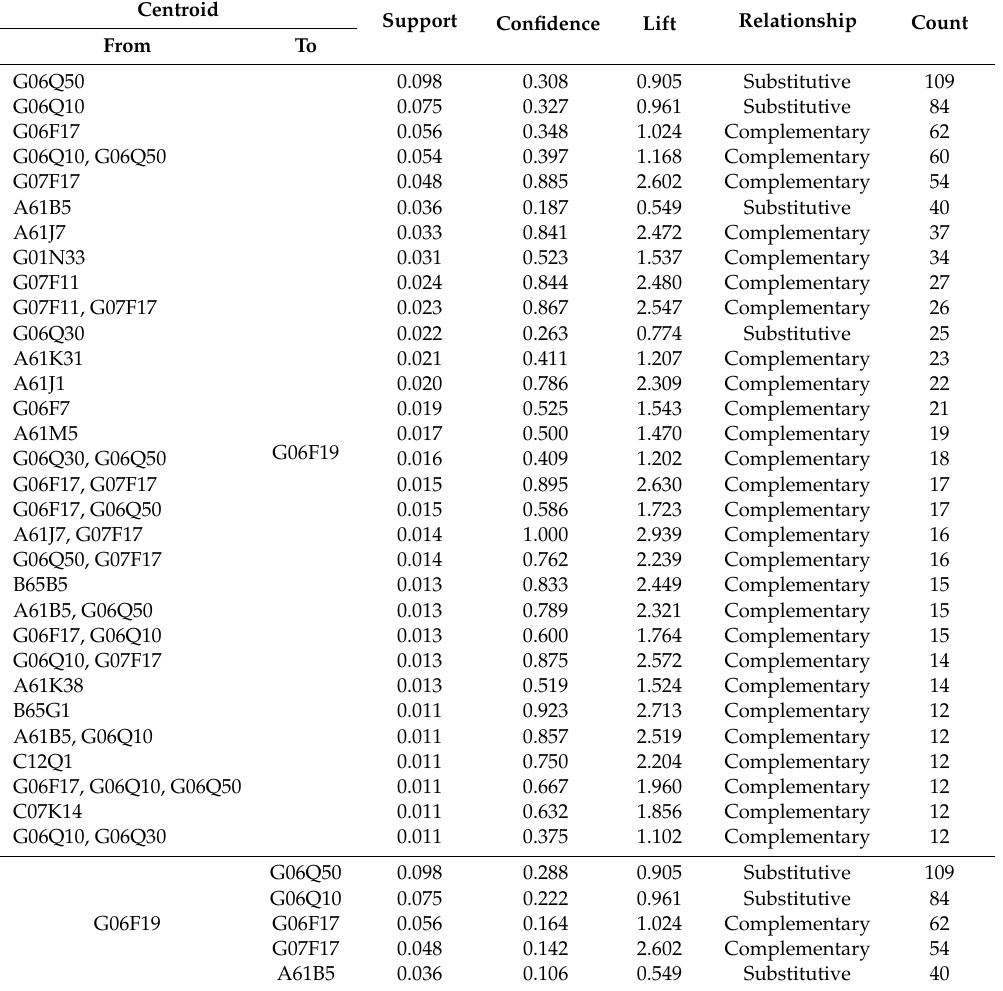
Table A5. Relationships of clusters in the data science-based pharmaceutical innovation period (2008–2015).